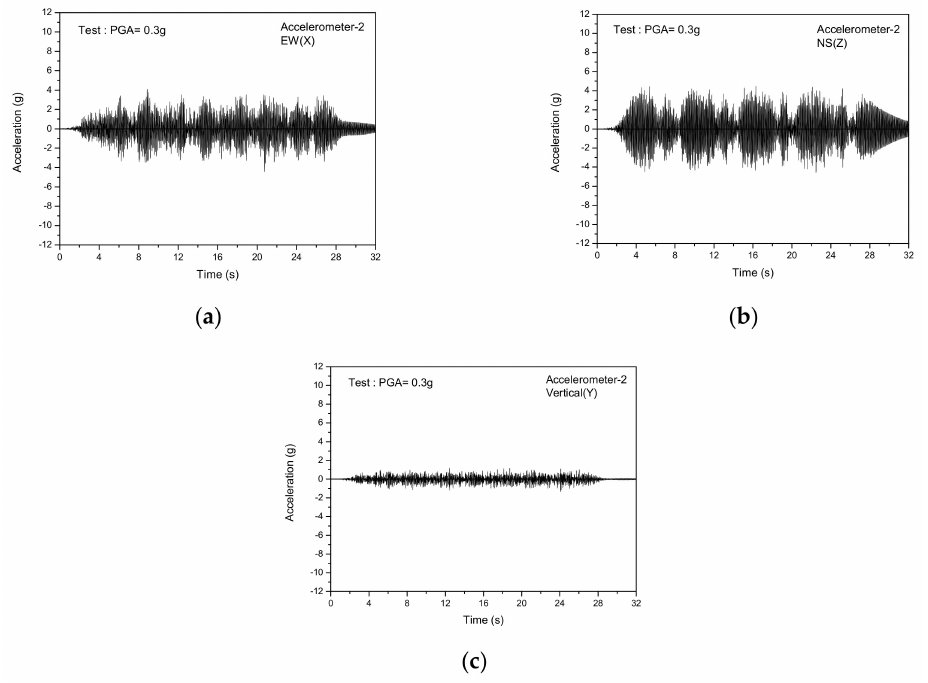
Figure 11. Test results of acceleration responses at Accelerometer-2 for PGA = 0.3 g: ( a ) EW (X); ( b ) NS (Z); ( c ) V